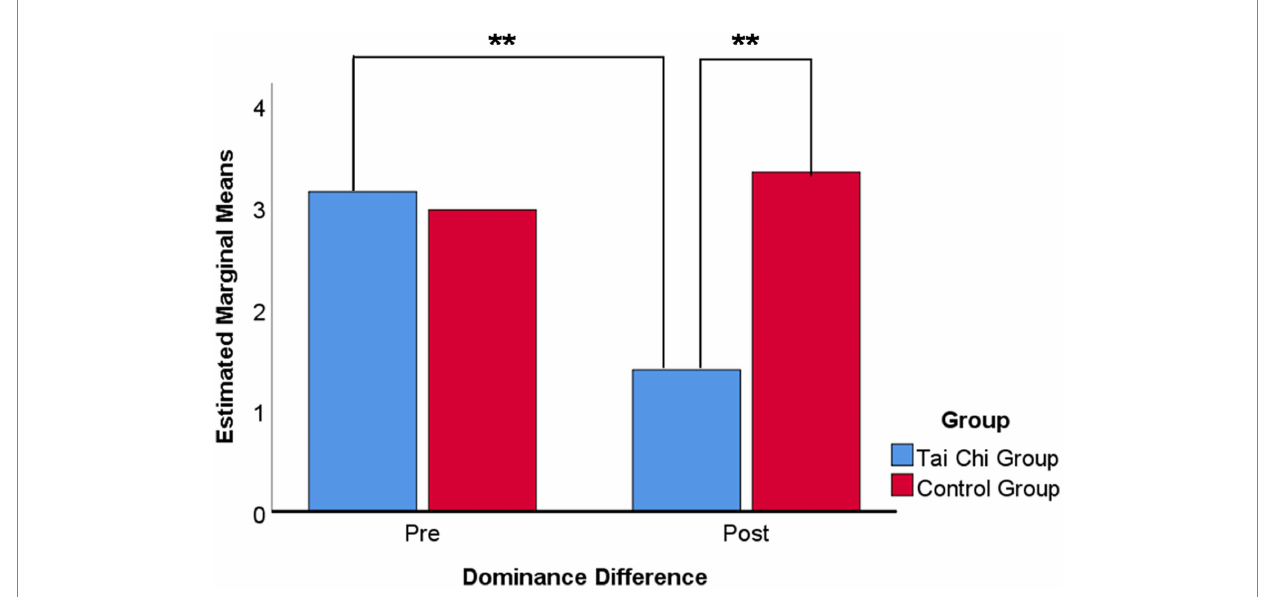
FIGURE 8 Multiple means comparison of dominance difference on emotion regulation ability. Bonferroni adjustment for multiple comparisons. *** p -value <0.001, ** p -value <0.01, * p -value